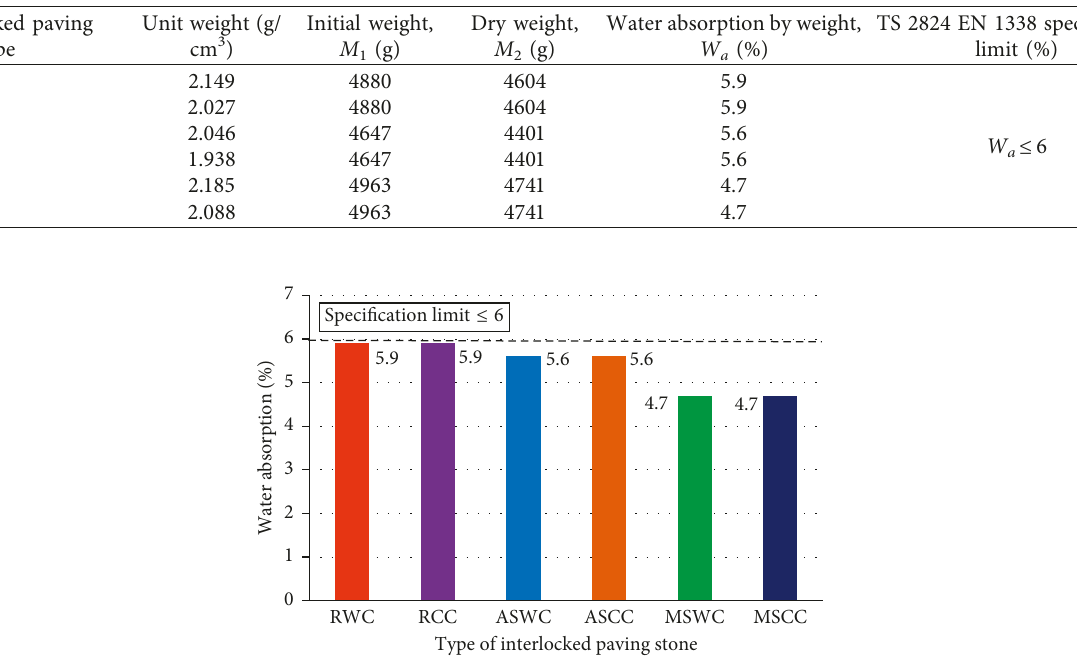
Figure 7: Results of the absorption test for each type of interlocked paving